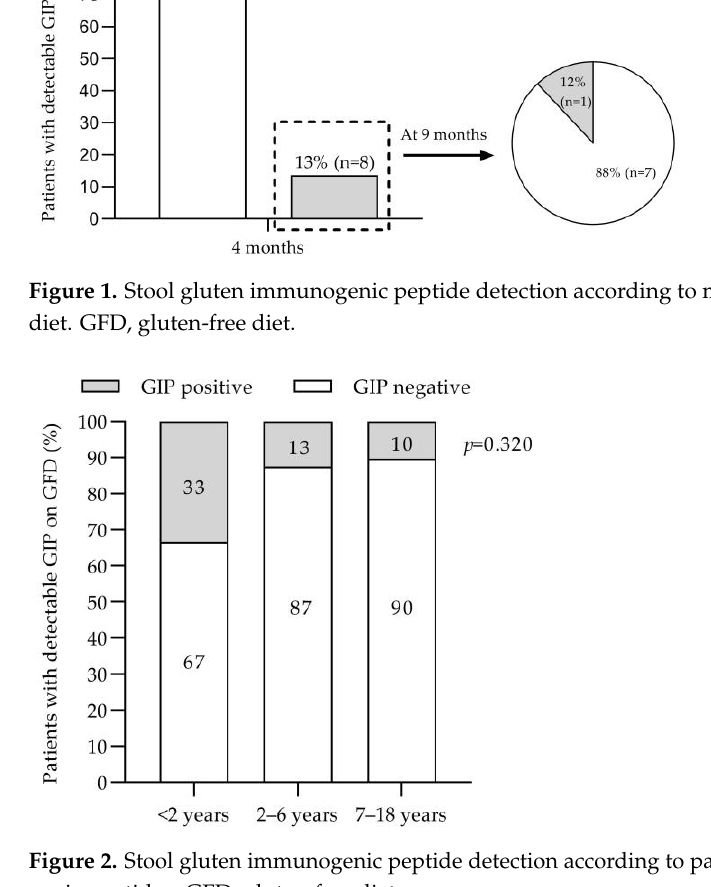
Figure 2. Stool gluten immunogenic peptide detection according to patient age. GIP, gluten immu- nogenic peptides. GFD, gluten-free diet.